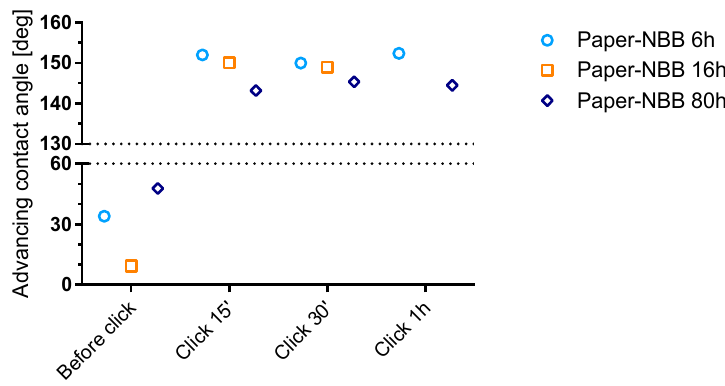
Figure 9. Results of the advancing contact angle of Paper-NBB samples before and after click functionalization with C14 with increasing irradiation time. Error bars are smaller than the used data symbols.